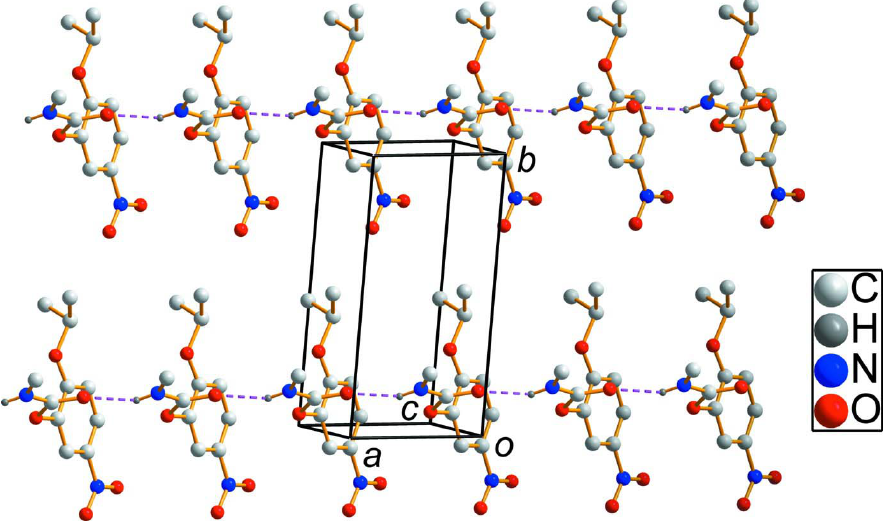
Figure 2 Perspective view of the supramolecular network along a axis built from strong intermolecular N—H···O hydrogen bonds (dashed lines). H atoms not involved in hydrogen bonds have been